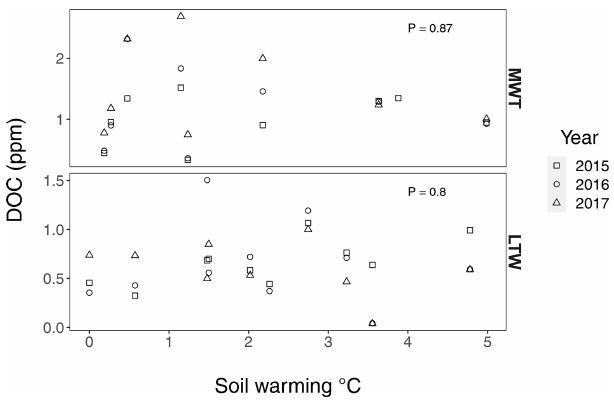
Figure B6. Dissolved organic carbon (DOC) in medium-term warmed (MTW) and long-term warmed (LTW) grassland during summer 2015, 2016 and 2017. No DOC change was observed with soil warming in the SWT ( P = 0 . 95) or in the LTW ( P = 0 . 8), meaning that carbon inputs into deeper soil layers remained con- stant over the whole soil temperature gradient. Statistical analysis was done with a linear mixed-effects model with soil warming as an explanatory variable and the sampling year as a random factor. Criteria for normality and homoscedasticity were met. Dissolved organic carbon was sampled at an approximate depth of 30cm with Prenart Super Quartz (Prenart Equipment ApS, Frederiksberg, Den- mark) soil water samplers, installed around 1 October 2014. The samples were always inserted from “downslope”, where the soil was deep enough. Analyses of the samples was done at the IGN Biochemistry Lab, University of Copenhagen. ( n = 25 and n = 29 for MTW and LTW grassland respectively.)